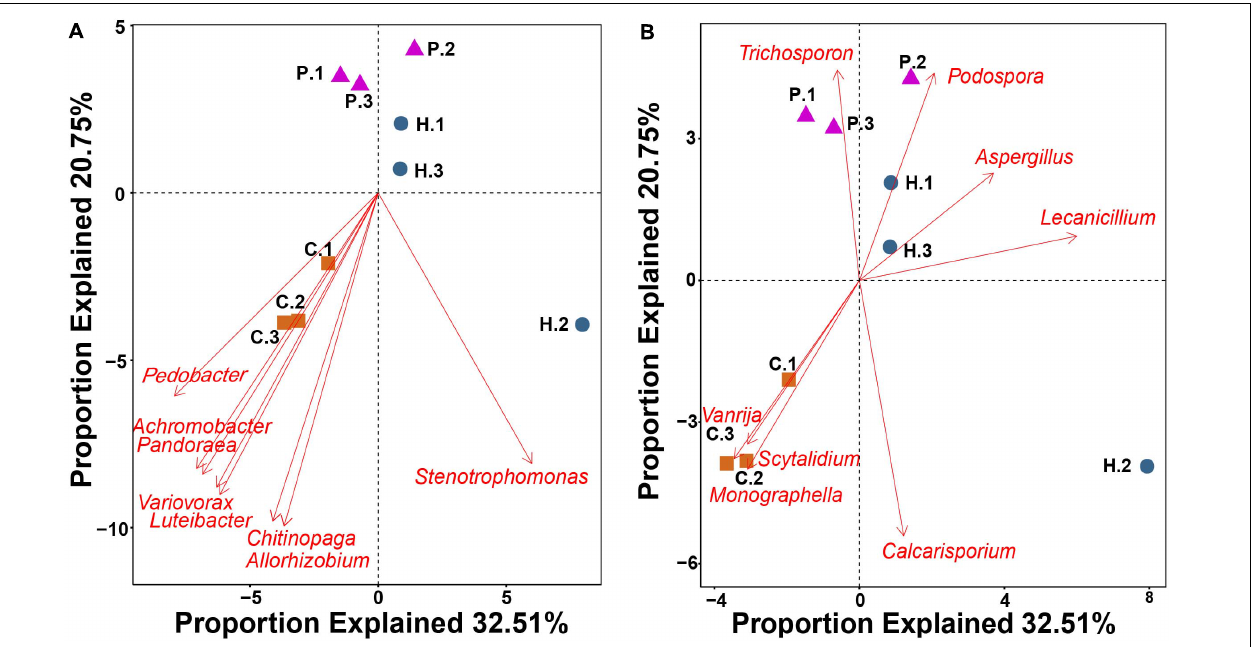
FIGURE 5 | RDA showing the relationship between 16 bacterial (A) and fungal (B) genera with a highly significant correlation ( P < 0.01) with functional gene structure within Thelephora ganbajun tissue compartments (C, context; H, hymenophore; P, pileipellis). The top 60 genera from amplicon data in the three compartments were used as vectors in the redundancy